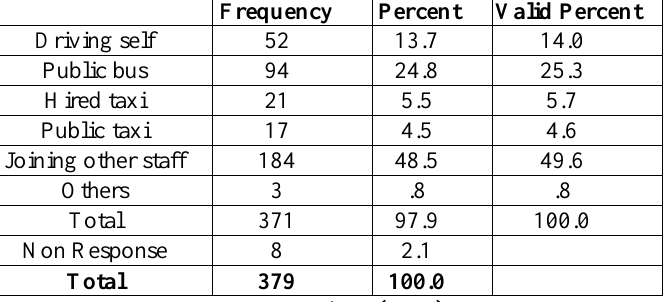
Table 4: Alternative to get to work.